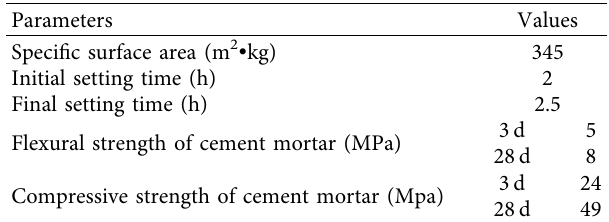
Table 2: Basic properties of cement.